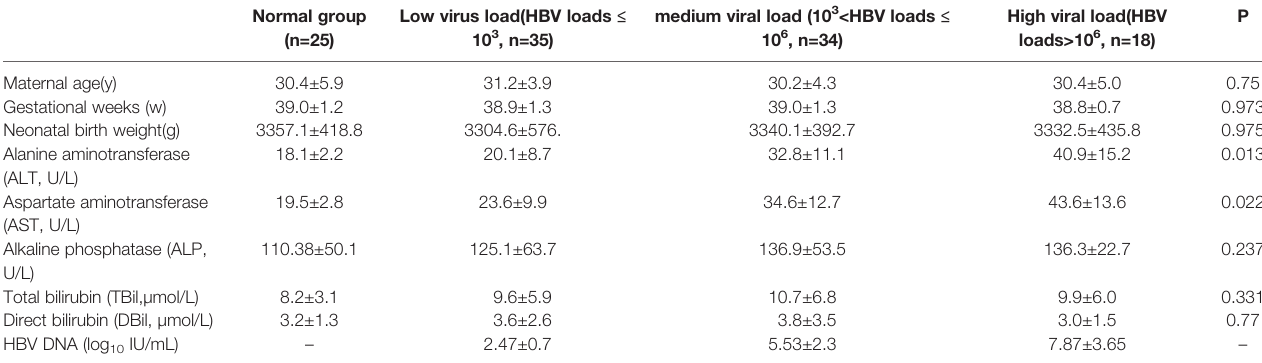
TABLE 1 | Clinical data of different HBV viral load